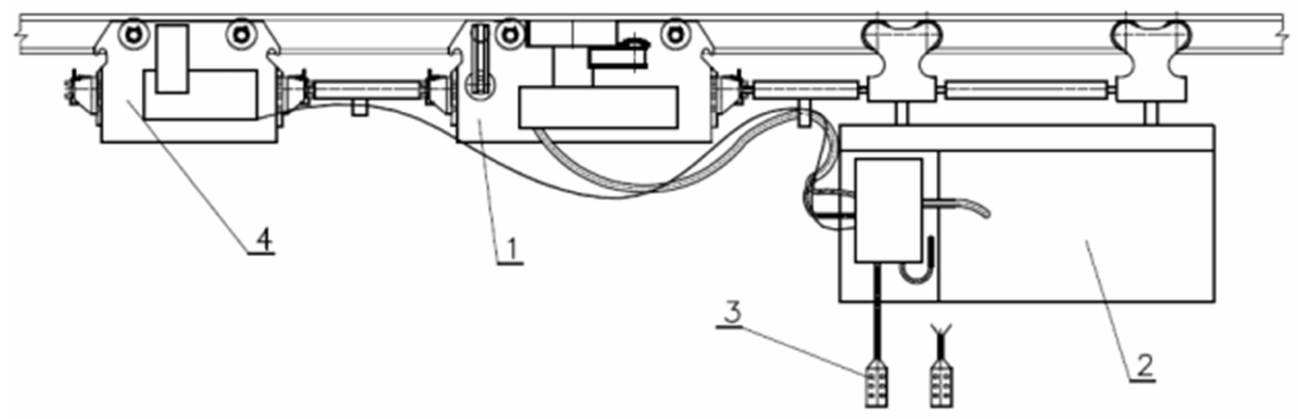
Figure 1. Layout of the suspended battery vehicle (PCA-1) (1—driving trolley, 2—power supply unit, which includes battery bank and necessary auxiliary devices such as control, security, charging systems, electronic systems, etc., 3—control cassettes or alternatively radio remote control panel, 4—braking